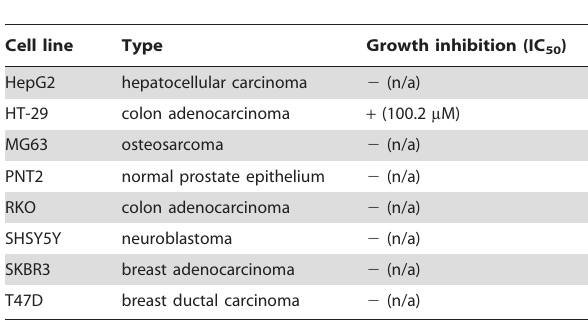
Table 1. Cytotoxicity of 1 towards a panel of human cell lines. ( + growth inhibition observed, 2 no growth inhibition